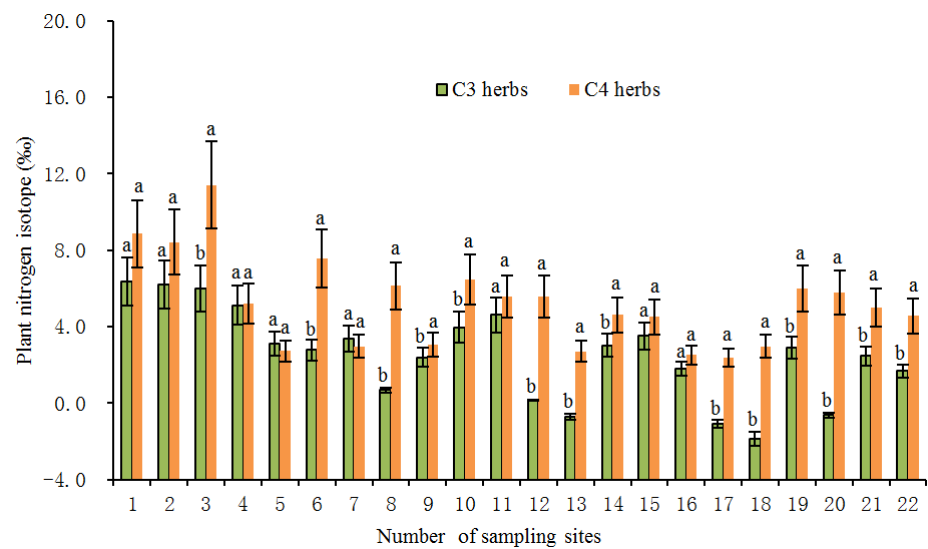
Figure 2. Average foliar δ 15 N of C3 and C4 herbs at each sampling site in the study transect. The numbers of the sampling sites correspond to the serial number in Table 3. All the values are represented as mean ± SD (standard deviation) at each sampling site. Different letters at each site indicate significant differences according to Duncan’s single-factor variance test at the 5% level.